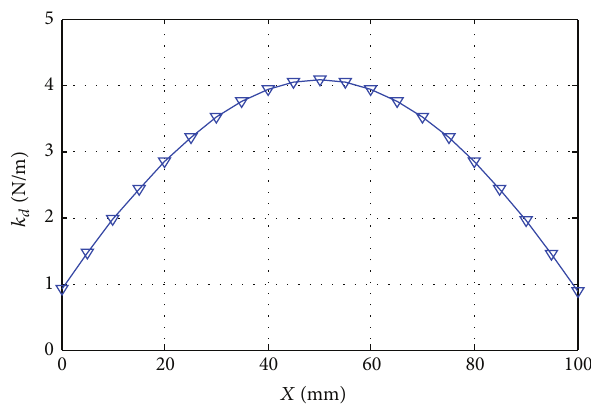
(c) Change of minimum dynamic stiffness of workpiece at different tool positions Figure 9: Change of dynamic characteristics of workpiece at different tool